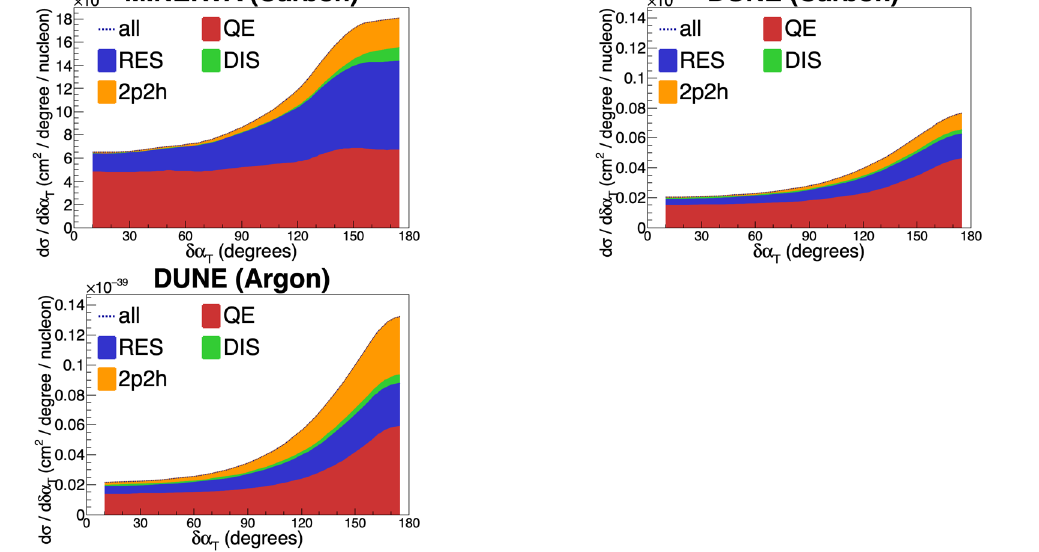
Figure 152. Differential cross section in the transverse boosting angle, δα T , as defined in Equation (35), for MINERvA ( left ) and for argon ( right ) in ND-GAr. The middle plot is for a carbon detector with the acceptance of ND-GAr to separate the detector design from the nucleus for the